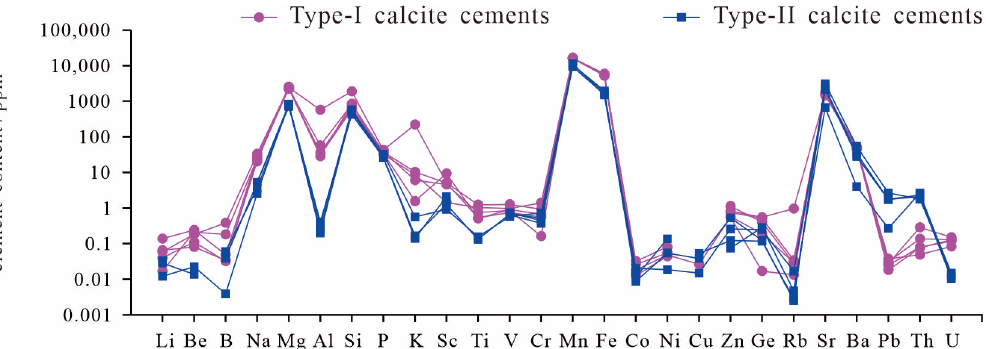
Figure 8. Characteristics of major elements and trace elements in two different types of calcite cements. Type-I calcite cements are from samples of W484 (2009.4 m), X522 (2041.06 m), S268 (1796.2 m), D167 (1252.1 m); type-II calcite cements are from samples of G6 (2001.75 m), S165 (1979.85 m), Y19 (1169.8 m).